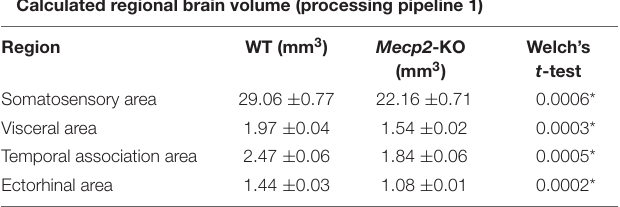
TABLE 2 | List of significantly altered each regional brain volume in Welch’s t -test (Processing pipeline 1). Calculated regional brain volume (processing pipeline